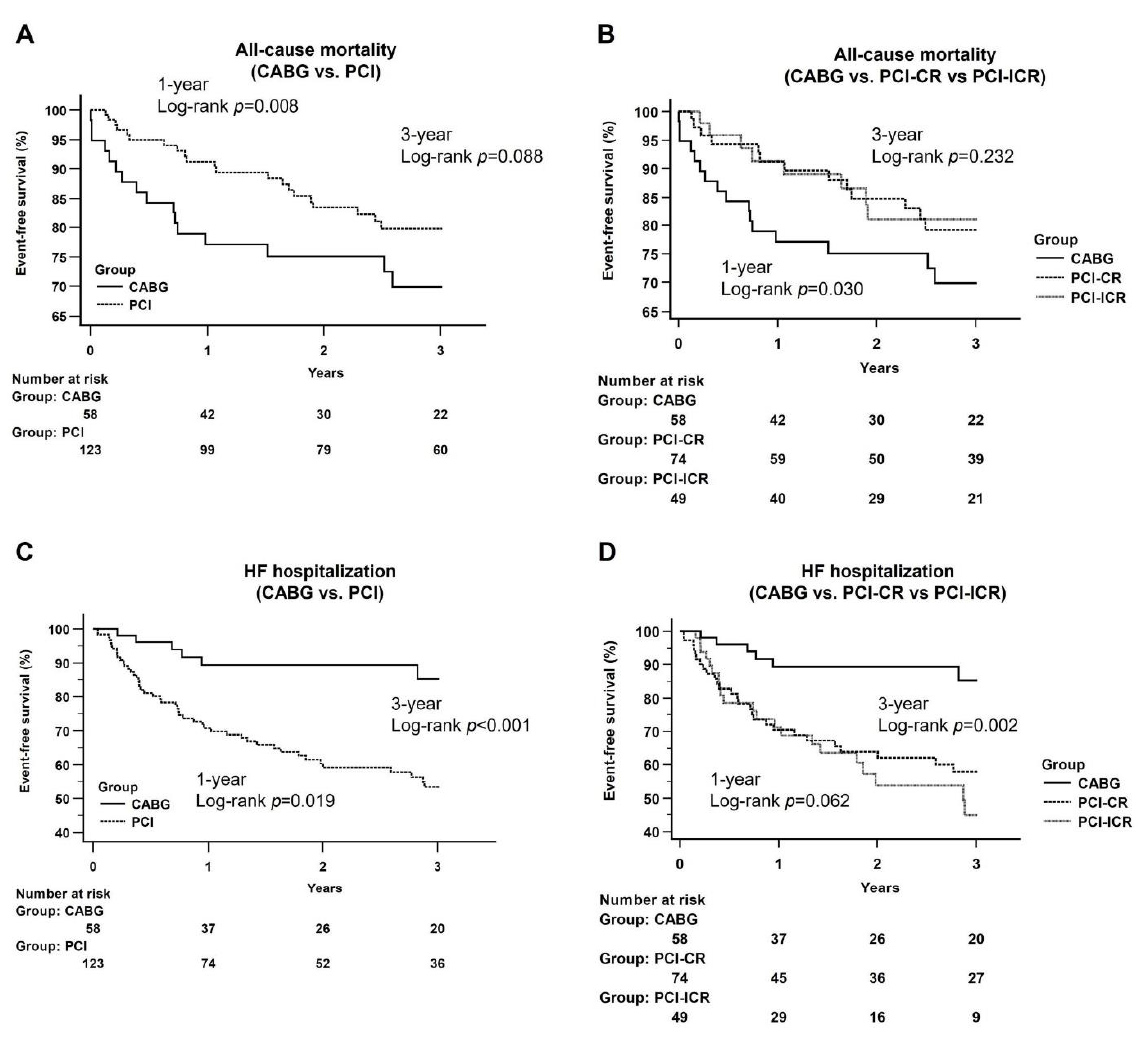
Figure 2. Kaplan–Meier curves of all-cause mortality and heart failure hospitalization between groups. ( A ) CABG vs. PCI: A higher incidence of all-cause mortality was noted at the one-year follow-up period (log-rank p = 0.008) and did not differ at the three-year follow-up period (log-rank p = 0.088); ( B ) CABG vs. PCI-CR vs. PCI-ICR: CABG group had a higher incidence of all-cause mortality at the one-year follow-up period (log-rank p = 0.030), and no significant difference was noted at the three-year follow-up period (log-rank p = 0.232). Abbreviation: CABG: coronary artery bypass grafting; PCI: percutaneous coronary intervention; CR: complete revascularization; ICR: incomplete revascularization; ( C ) CABG vs. PCI: CABG group had a lower incidence of HF hospitalization at one-year follow-up period (log-rank p = 0.019) and three-year follow-up period (log-rank p < 0.001); ( D ) CABG vs. PCI-CR vs. PCI-ICR: there was no significant difference at the one-year follow-up period (log-rank p = 0.062) and CABG group had a significantly lower incidence of HF hospitalization at three-year follow-up period (log-rank p = 0.002).